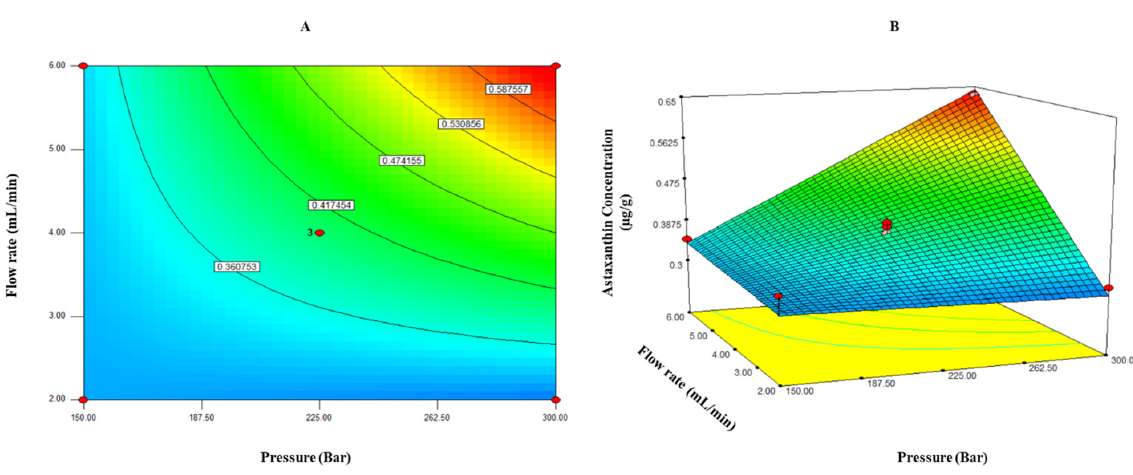
Figure 3. Contour plots ( A ) and response surface ( B ) for the effect of pressure (bar) and flow rate (mL/min) on the astaxanthin concentration of supercritical CO 2 extraction of lyophilized liquor.